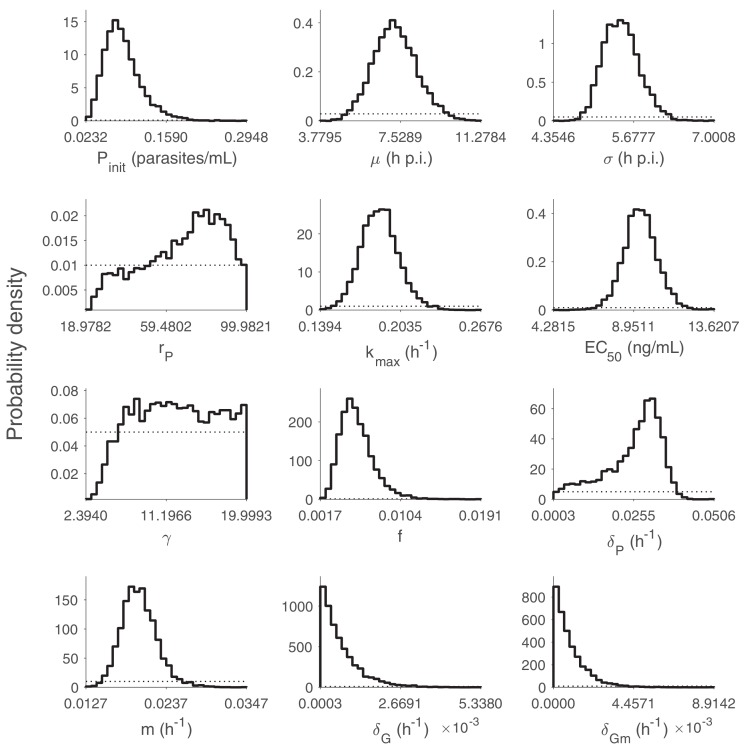
Marginal posterior distributions for the 12 population mean parameters (hyperparameters).5000 samples are used to generate the distributions. The dashed curves indicate the uniform prior distributions. p.i.: post-inoculation. Note that the y-axis is probability density instead of number of samples. Relevant details of the hyperparameters are provided in the Materials and methods in the main text.